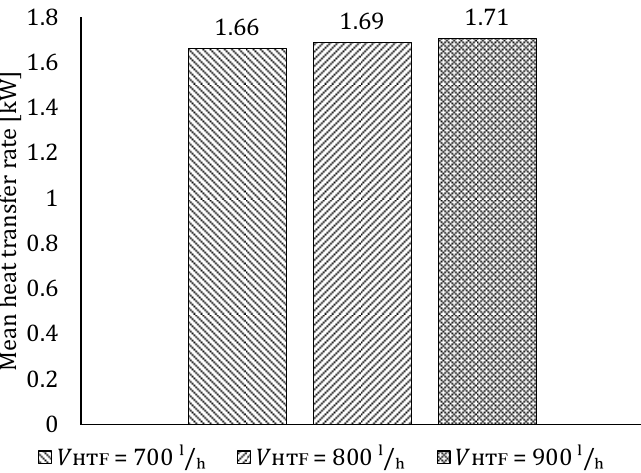
Figure 24. Comparison of mean heat transfer rate during solidification obtained numerically for different HTF flow rates, HTF inlet temperature 10 °C and initial PCM temperature 35 °C.